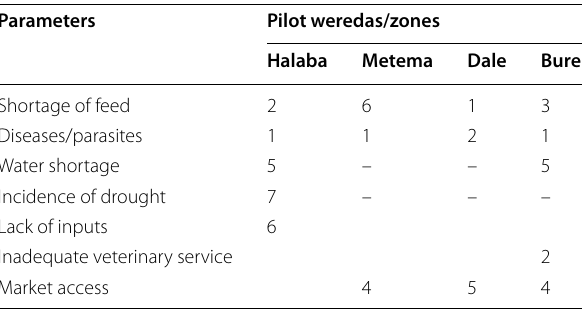
Table 6 Ethiopian goat production restrictions, ranked by smallholder farmers’ replies to represent pilot weredas. Source : Solomon et al.